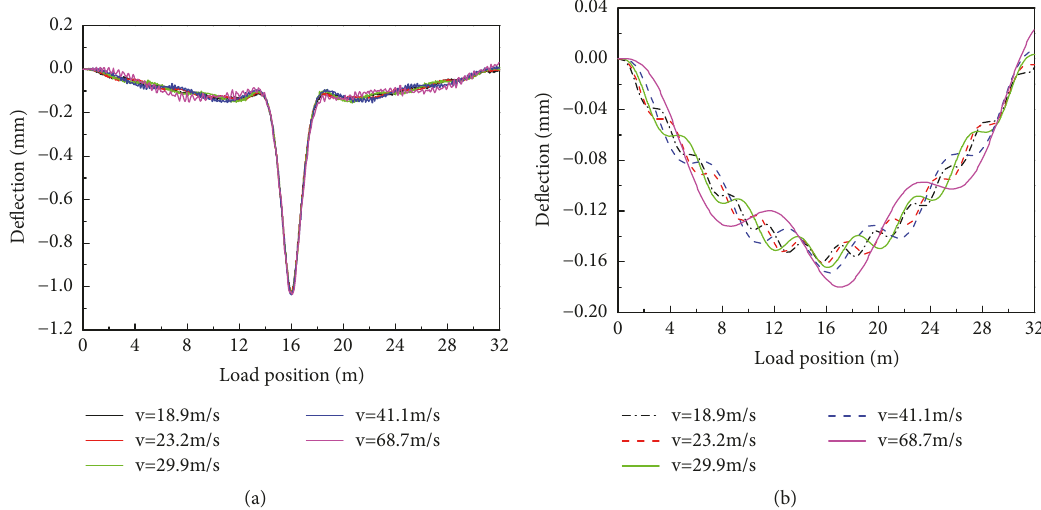
Figure 10: Mid-span deflection time-history for double simply supported rail-bridge system under resonance condition: (a) first beam; (b) second beam.